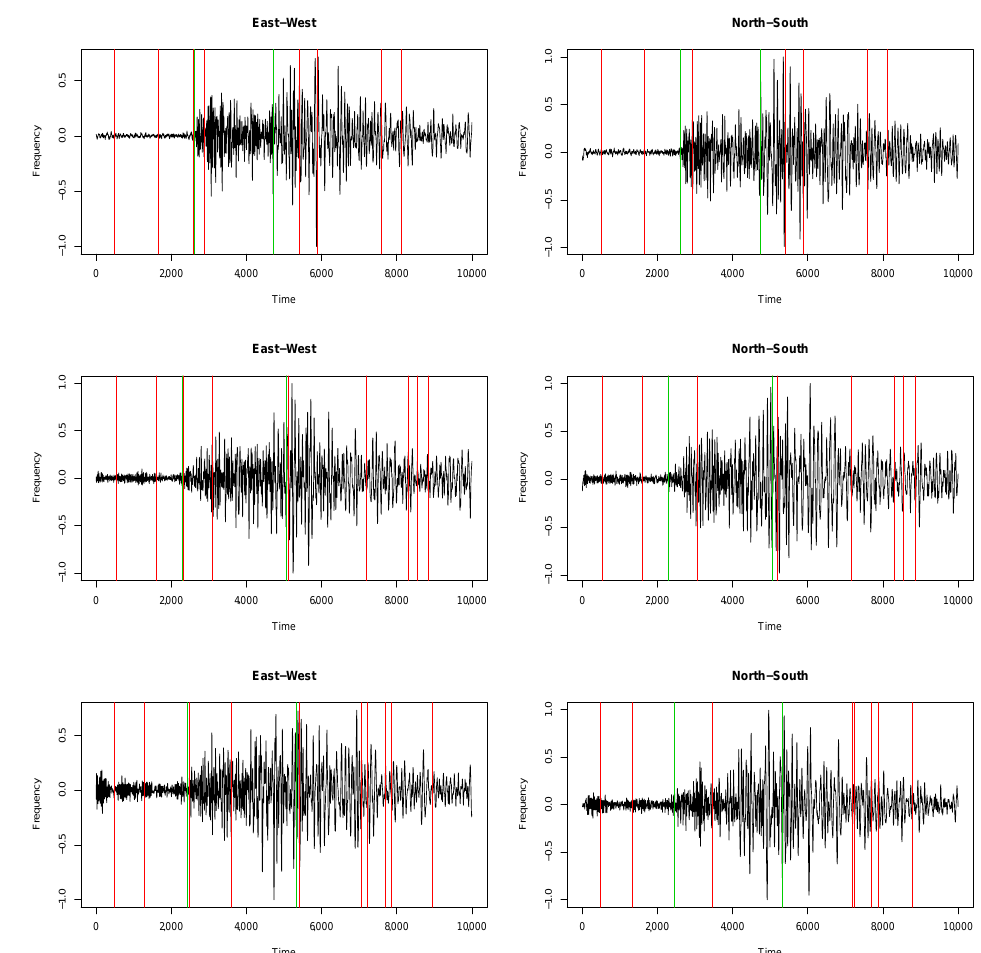
Figure 2. Waveforms of three earthquakes in the L’Aquila seismic sequence that occurred in 2009, detected by the BSSO—Busso seismic station (horizontal components). Red vertical lines: the K ∗ = 10 change points detected by the multivariate algorithm. Green vertical lines: the two change points selected by Algorithm 1 among the K ∗